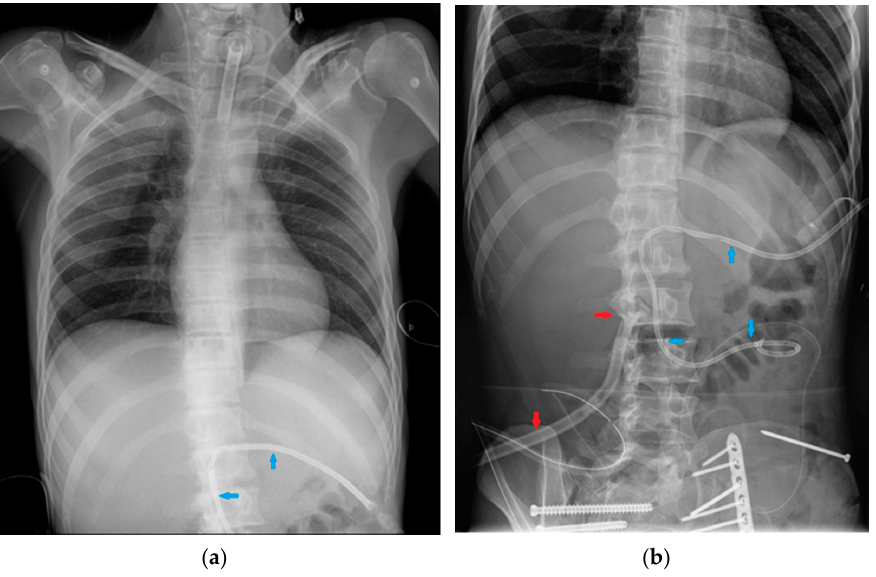
Figure 40. Image of a percutaneous transhepatic biliary drainage (PTBD) (blue arrows) partially included on the CXR ( a ) previously shown also in the Figure 4b (mispositioned left jugular CVC). The patient suffered a duodenum rupture after a car accident, so the PTBD was placed to drain the bile from the choledocum into the distal part of the duodenum, therefore bypassing the point of rupture, as shown in the abdominal X-ray ( b ); a Pezzer catheter (red arrows) was also placed in the duodenal lumen through the breach to further drain eventual other secretions. Multiple other drainage tubes as well as metallic screws and plate are present.